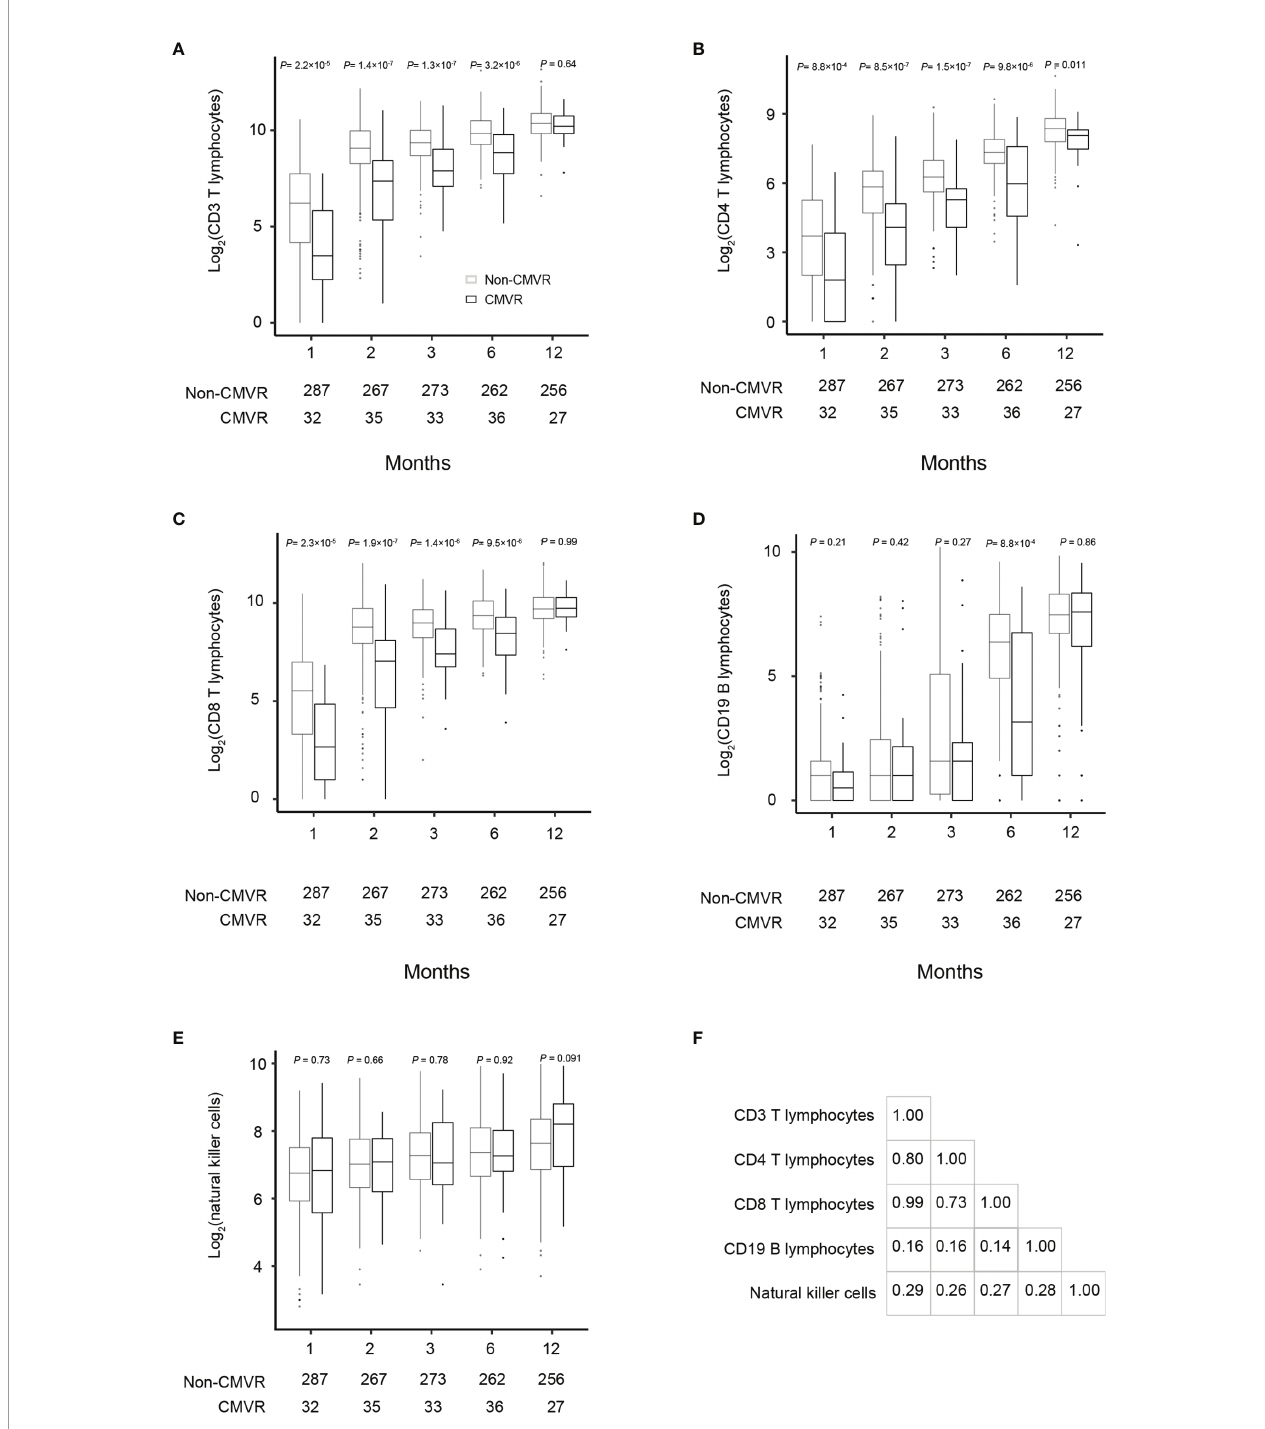
FIGURE 2 | Comparisons of the total lymphocyte, CD3, CD4, CD8, CD19 and natural killer cell counts at 1, 2, 3, 6, and 12 months after hematopoietic stem cell transplantation between the CMVR patients and those who did not develop CMVR (A – E) . The number of samples used in each time point was indicated in each fi gure. Based on the fact that most CMVR occurred from the third month after transplantation, Pearson correlation was used to explore the correlation between lymphocytes. The data were assessed by the Pearson correlation coef fi cient indicated a signi fi cant correlation between CD3, CD4 and CD8 in the third month after transplantation (F)